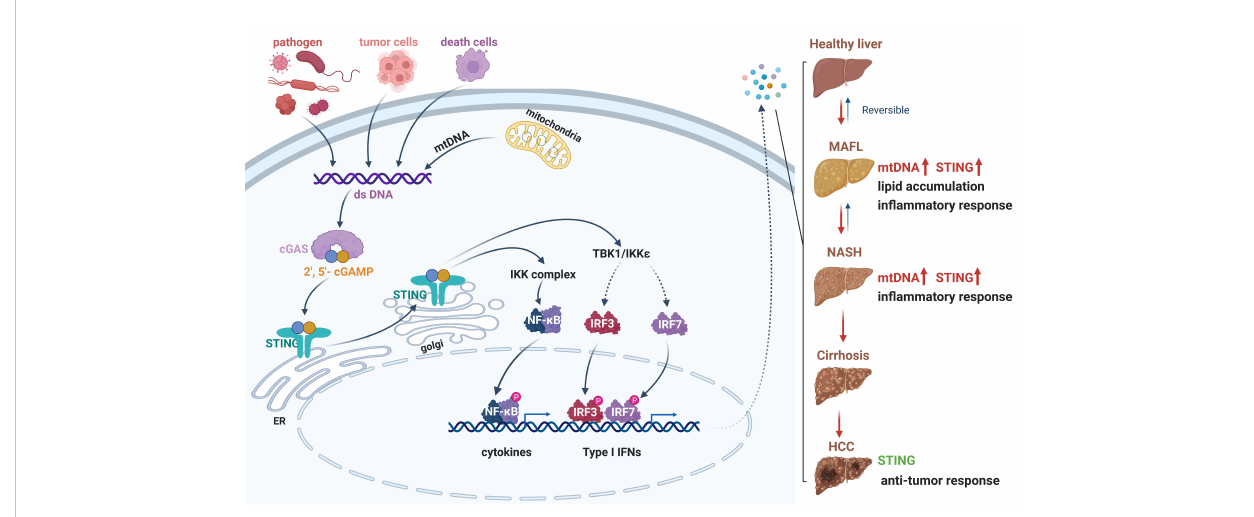
FIGURE 2 The cGAS-STING signaling pathway in the progression from NAFLD to HCC. A schematic detailing cytosolic dsDNA, which occurs through pathogen infection, tumor cells, death cells or cellular stress, can be recognized by cGAS. Enzymatic activation of cGAS results in the synthesis of 2 ′ -3 ′ cGAMP. The binding of cGAMP enables STING translocation from ER membrane to Golgi, then recruits TBK1 and IKK complex. The phosphorylation of IRF3 and NF- k B by TBK1 and IKK enable these transcription factor dimerization and translocation to the nucleus to induce gene expression of several cytokines, type I interferons, and chemokines. Activation of cGAS-STING signaling axis could promote lipid accumulation, in fl ammation, or anti-cancer responses in different stage of liver disease. dsDNA, double-stranded DNA; cGAS, cyclic GMP-AMP synthase; 2 ′ -3 ′ cGAMP, 2 ′ 3 ′ cyclic GMP-AMP; STING, stimulator of interferon genes; ER, endoplasmic reticulum; TBK1, TANK-binding kinase 1; IKK, I k B kinase; IRF3, interferon regulatory factor 3. Red, accelerative effect; Green, protective